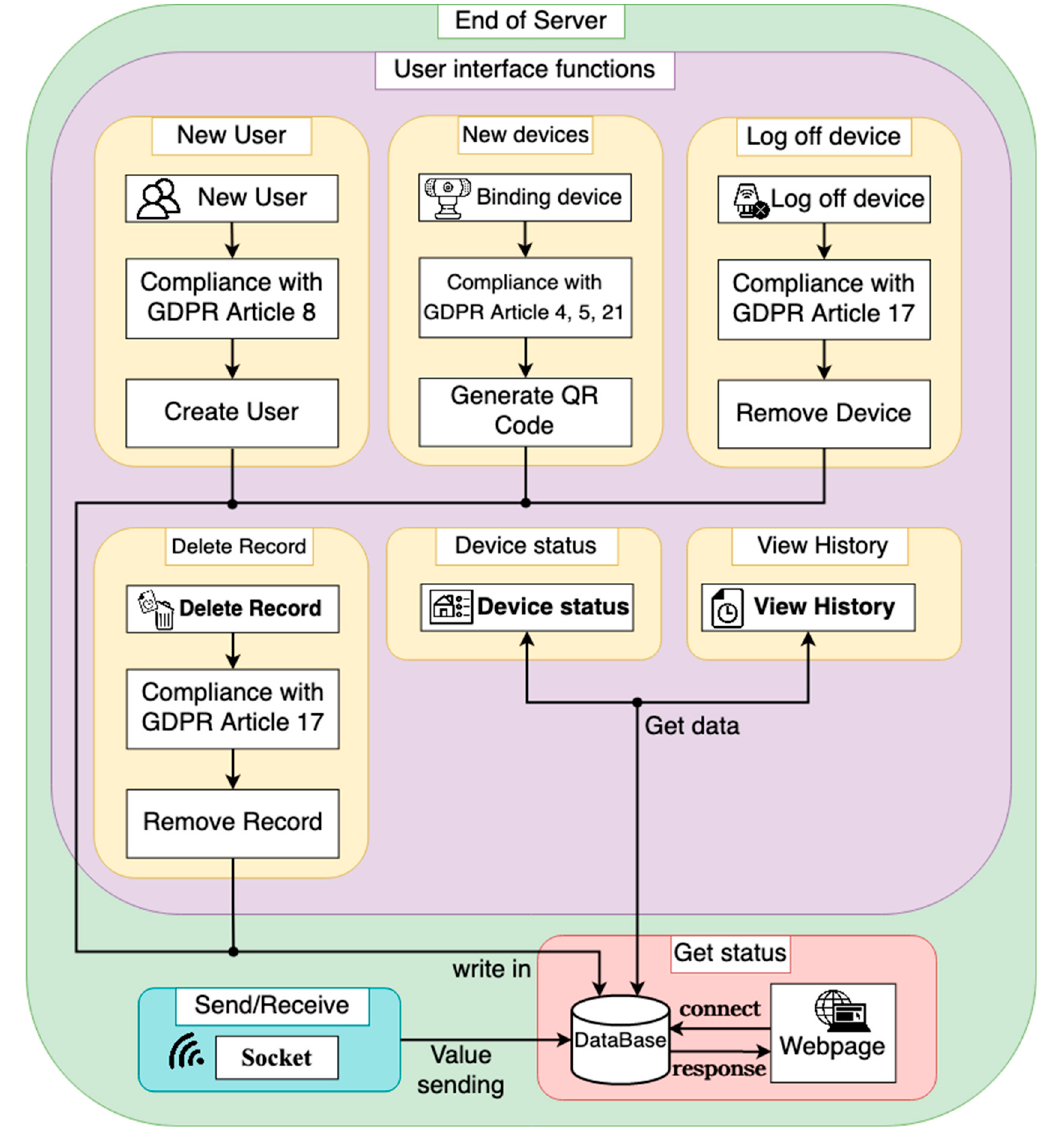
Figure 3. Schematic diagram of server module. Table 3. Data